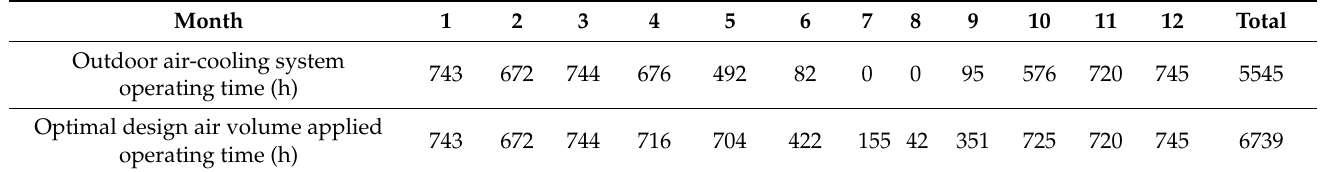
Table 8. Expected monthly operation time of the outdoor air-cooling